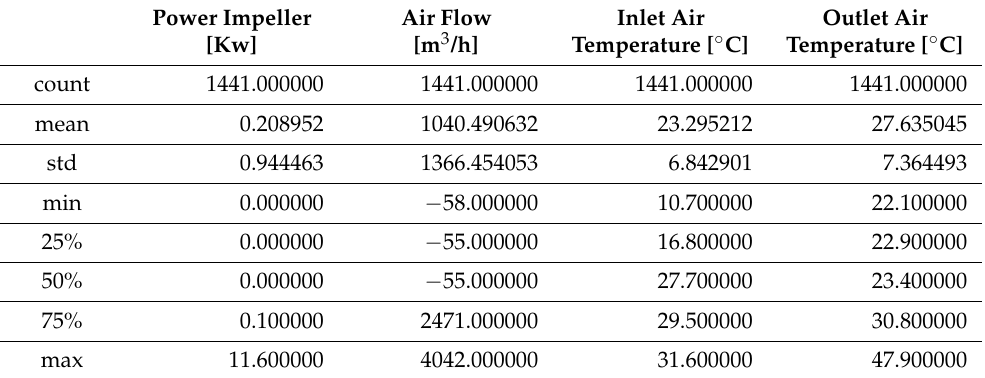
Table 1. Example of signals used for the experiment.